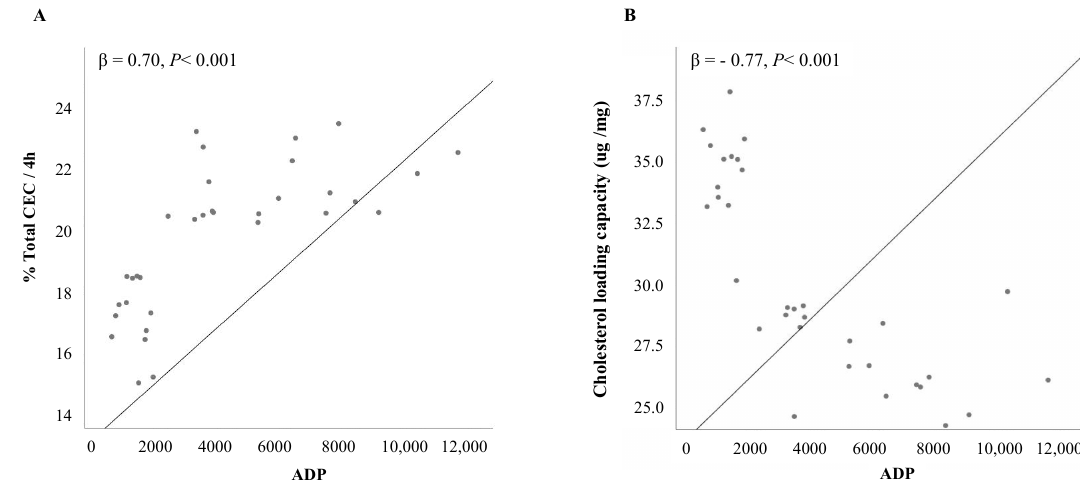
Figure 6. Linear regression analysis between CEC, CLC and adiponectin levels. ( A ) shows linear regression analysis between CEC and concentrations of adiponectin. R-squared = 0.49 ( B ) shows linear regression analysis between CLC and concentrations of adiponectin. R-squared = 0.60. ADP, adiponectin.